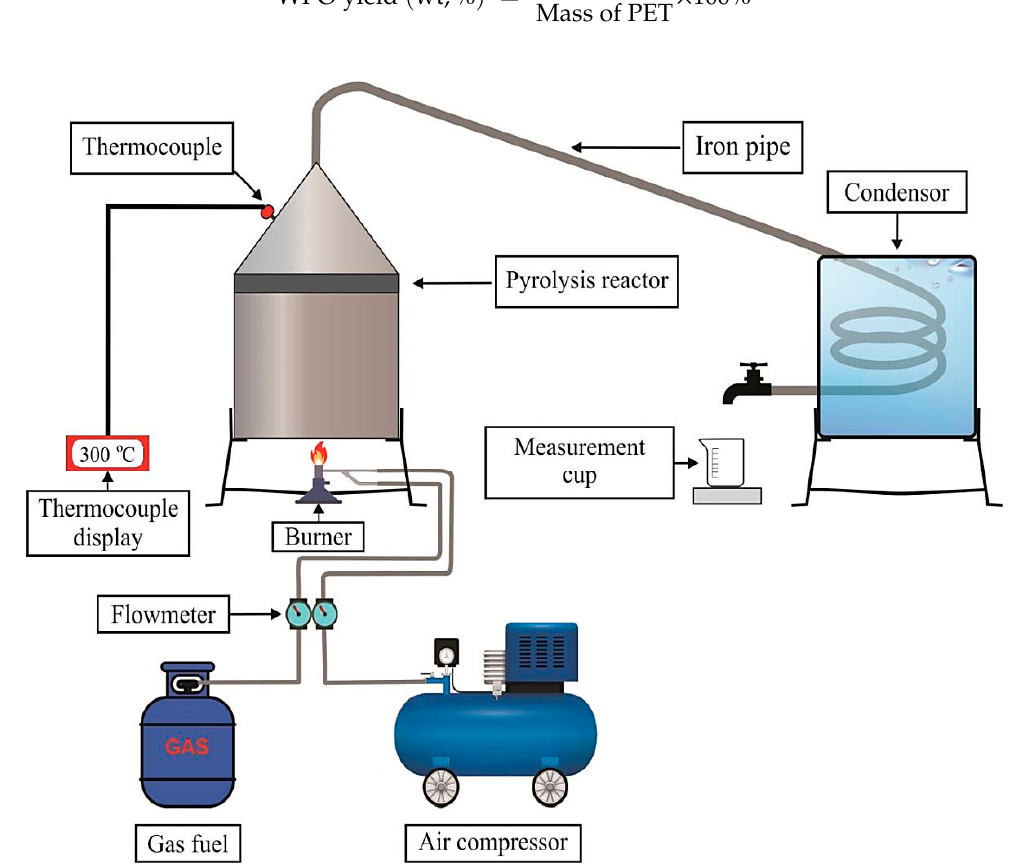
Figure 2. Schematic diagram for converting plastic waste to oil via pyrolysis.